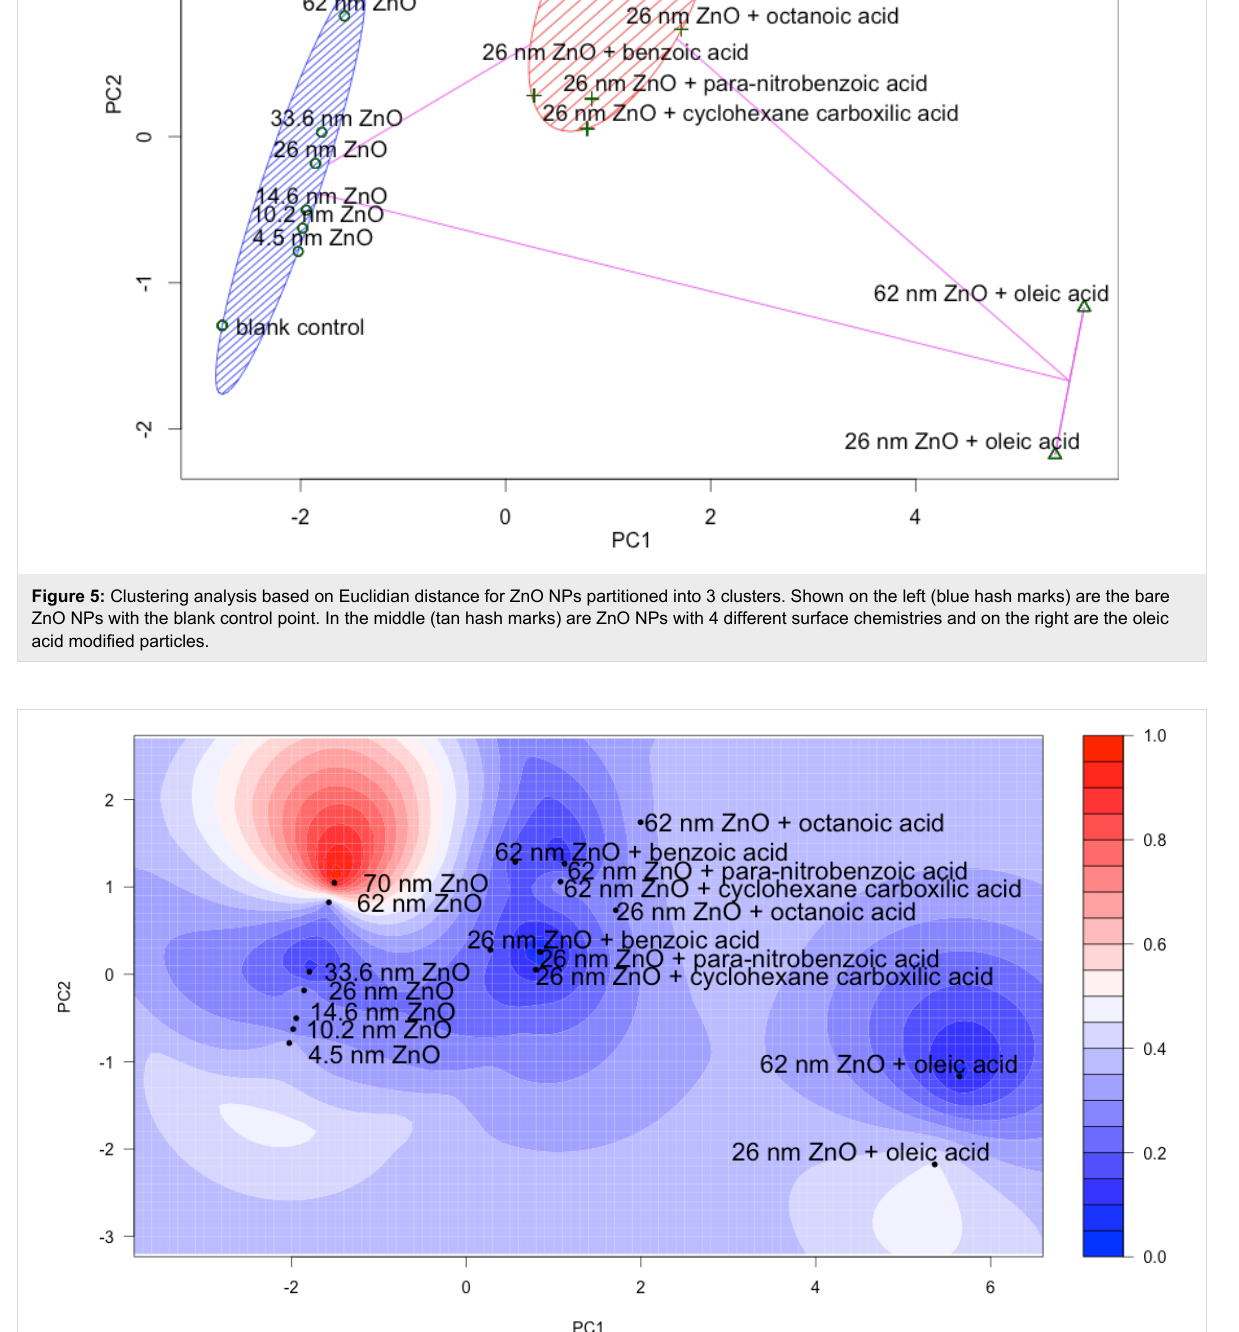
Figure 6: Kriging estimation contour map for embryonic zebrafish exposed to 250 mg/L of each type of zinc oxide nanoparticle using the first two surface chemistry-based principal components as the coordinates and 120 hpf total mortality as response. The coefficient of determination was found to be